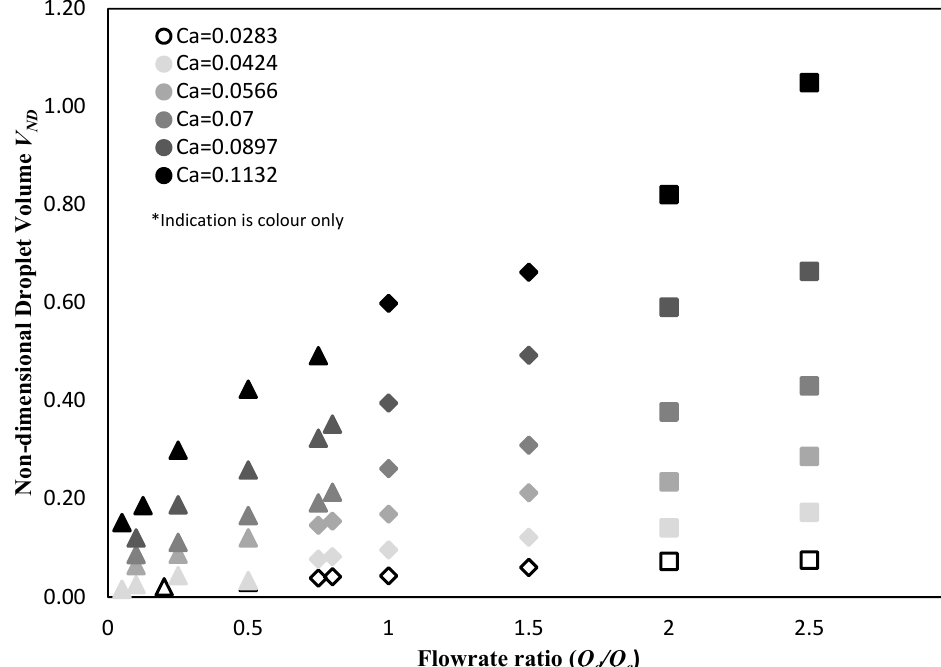
Figure 5. Non-dimensional droplet volume plotted against the flow rate ratio between the dispersed phase flow rate and the continuous phase flow rate for different capillary numbers. The colour legend of this graph indicates the colour scheme used for the different capillary numbers. Triangles correspond to dripping, diamonds to transition, and rectangles to squeezing.